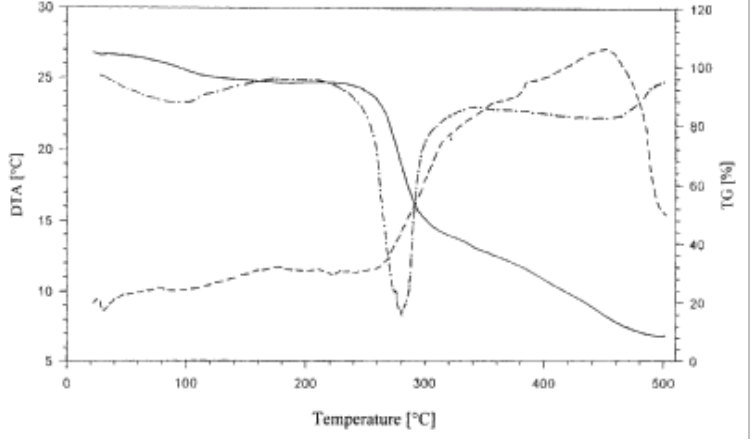
Figure 5. Thermogram (TG, DTG, DTA) of casein/PPCS 2:1 complex in the 25-500 o C